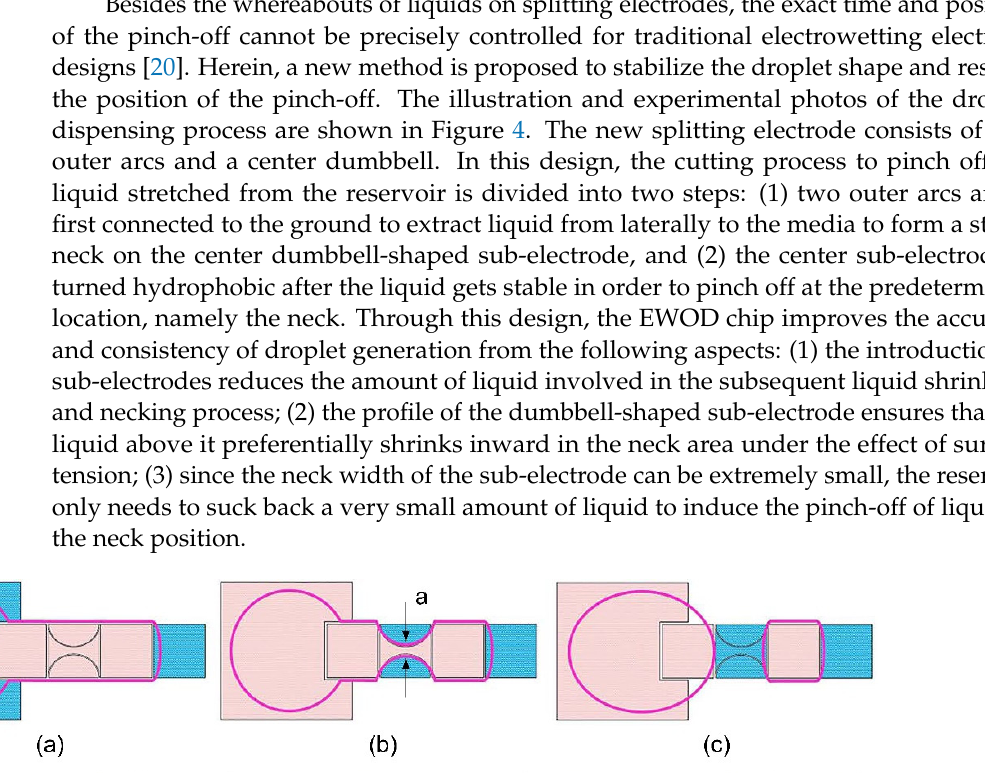
Figure 3. Droplet dispensing process with a new electrode design. ( a – e ) Schematic of the dispensing process. ( f ) Volume variation of droplets dispensed consecutively with the sub-electrodes of differ- ent widths. Each dot is averaged over 5 measurements, and error bars are not shown for visual clarity.